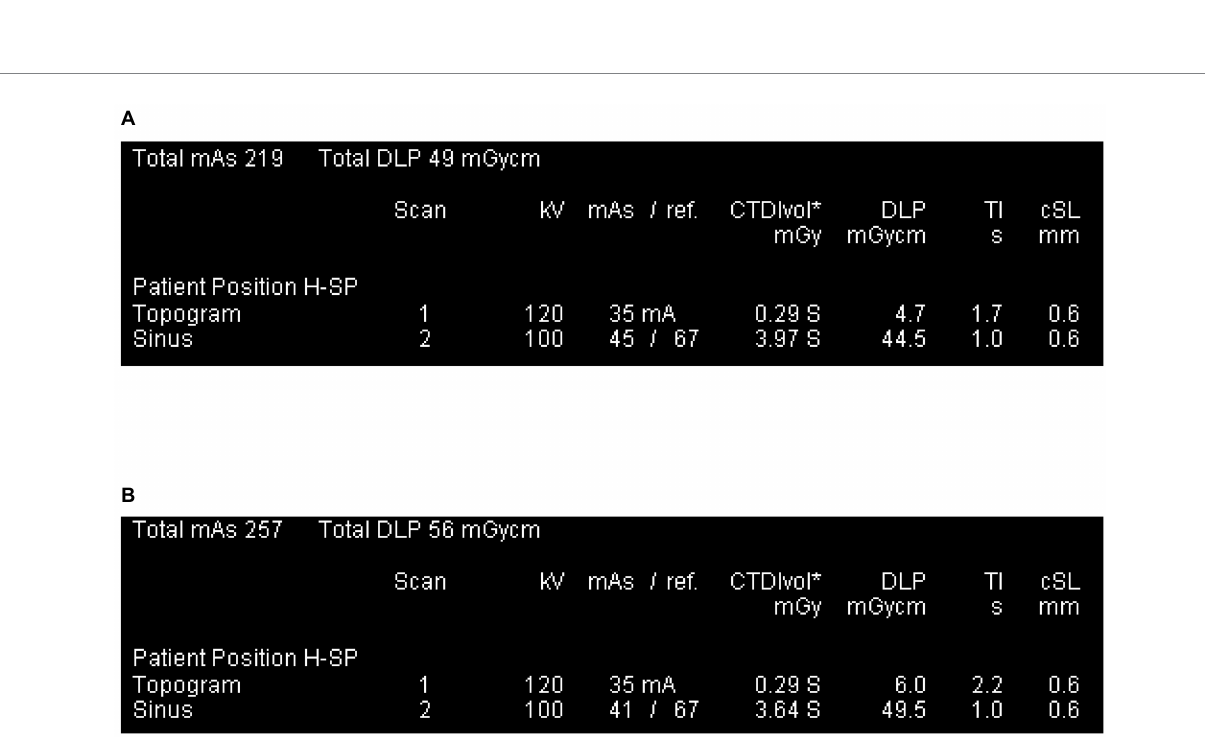
A/N represented the adenoid size. According to A/N, participants were classified into mild adenoid hypertrophy group(A/N ≥ 0.6) and severe adenoid hypertrophy group (A/N ≥ 0.7) (11).